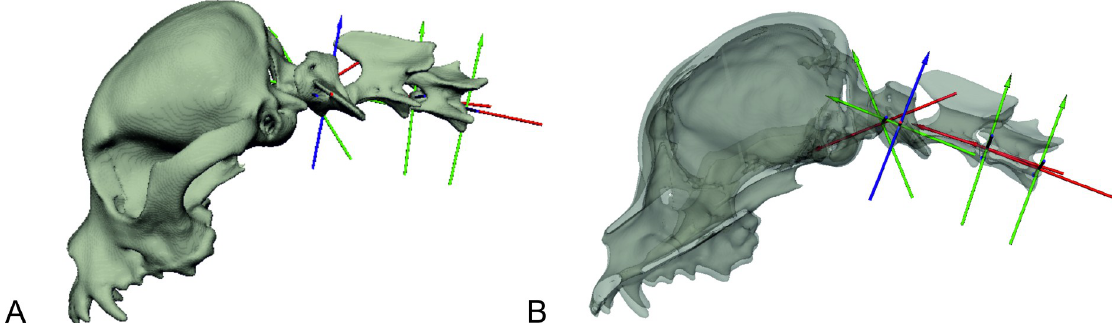
Fig 2. Cranial cervical spine and skull as bone models with virtual intervertebral joints. A: bone model of the skull and first three cervical vertebrae of a CKCS with coordinate axis of the virtual intervertebral joints; B: same bone model in a semi-transparent